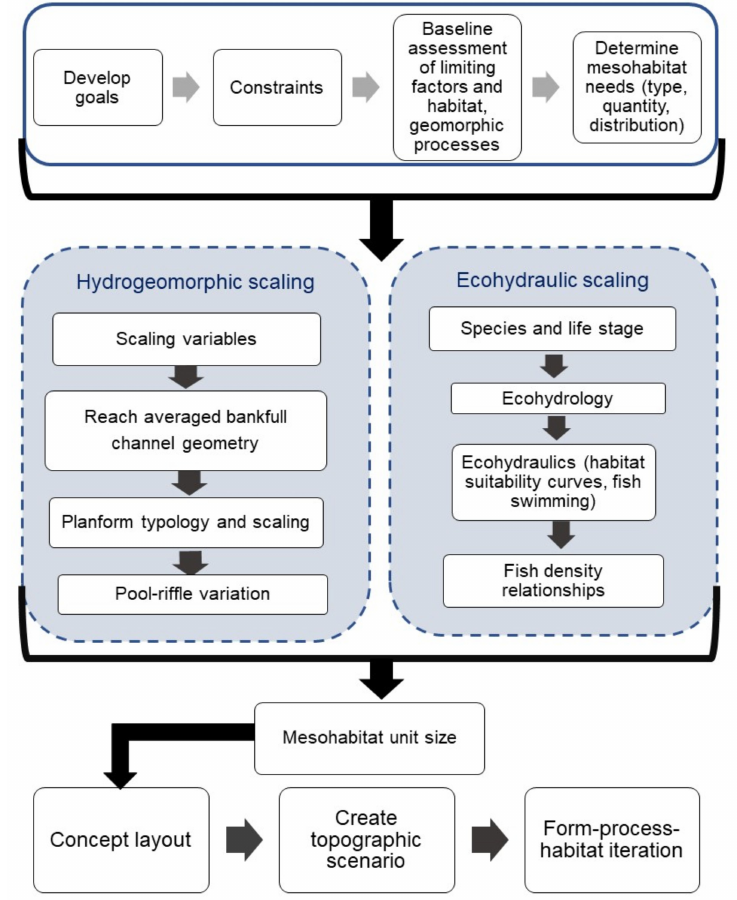
Figure 3. Flow chart illustrating steps in developing Pacific salmonid habitat restoration designs. Early phases identify goals and constraints and develop baseline assessments of limiting factors and geomorphic processes, which are then used to determine the type, quantity, and distribution of mesohabitat units. This paper deals with using hydrogeomorphic scaling and ecohydraulics (shaded boxes) to derive the size of geomorphic and mesohabitat units, which can then be used to develop the layout of concepts and topographic scenarios. Hydrogeomorphic scaling and ecohydraulics are shown as parallel because both are necessary and complementary components representing physical and biological